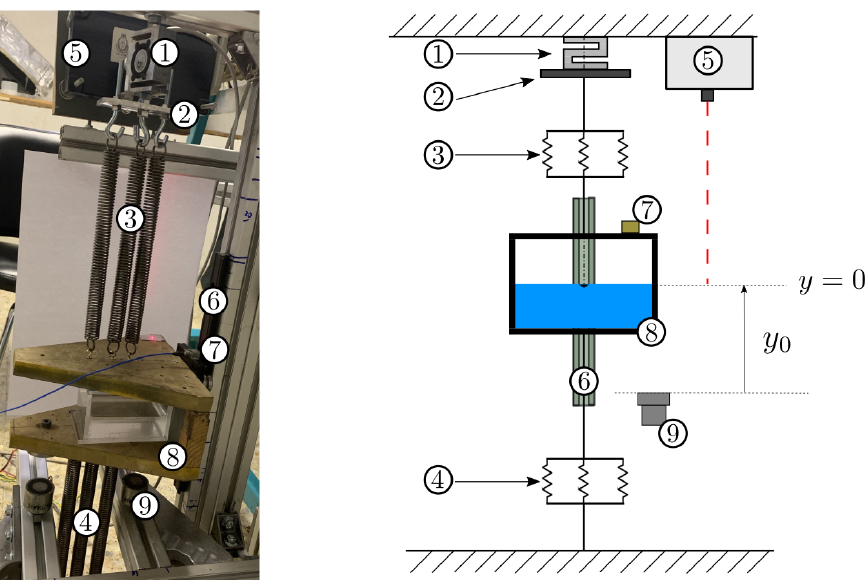
Figure 1. Snapshot of the experimental setup for the λ = 1/5 scale ( left ) and outline ( right ). (1) Load cell, (2) metallic plate with mass m p = 0.06 kg, (3) upper set of springs with stiffness constant k 1 = 2125 N/m, (4) lower set of springs with stiffness constant k 2 = 2125 N/m, (5) laser sensor, (6) mechanical guide, (7) accelerometer, (8) methacrylate tank and C-shaped wooden structure and (9) pair of solenoids acting as release